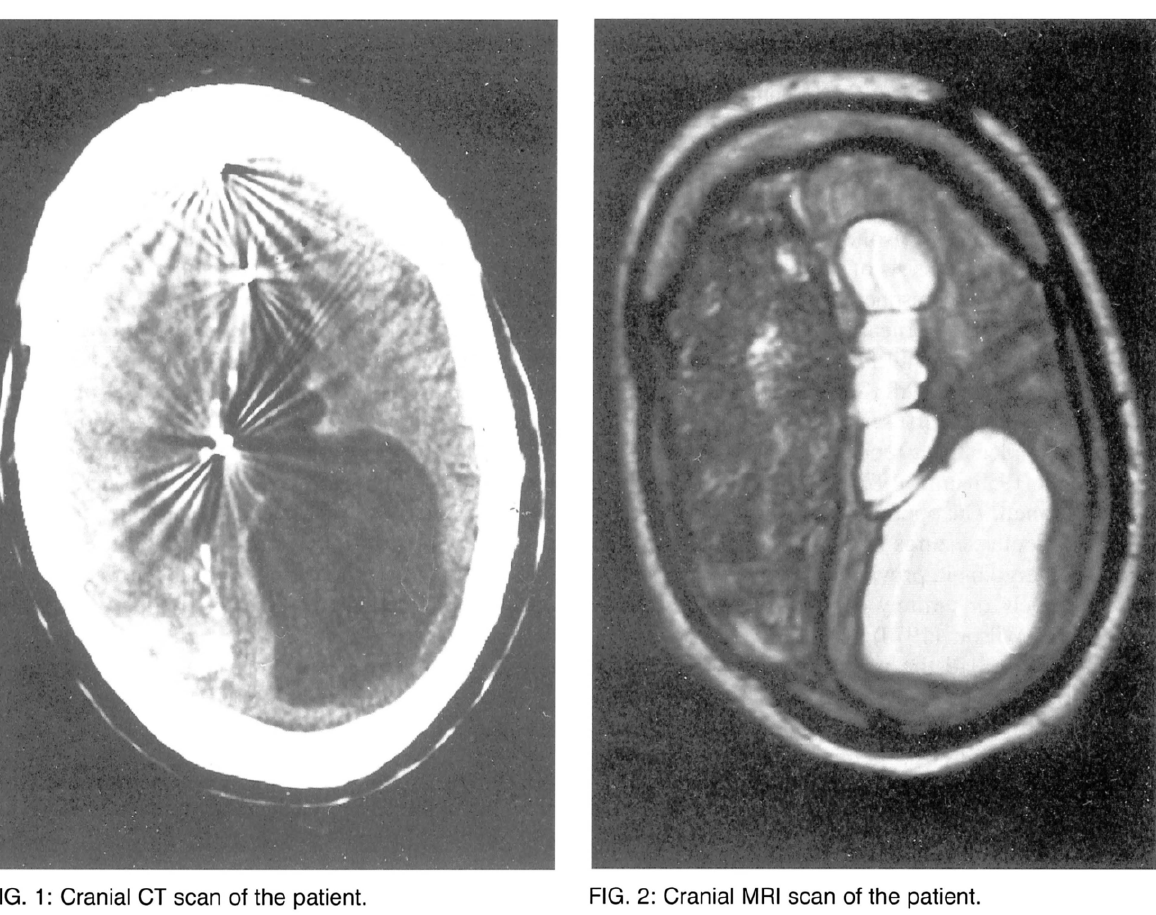
FIG. 1: Cranial CT scan of the patient. FIG. 2: Cranial MRI scan of the